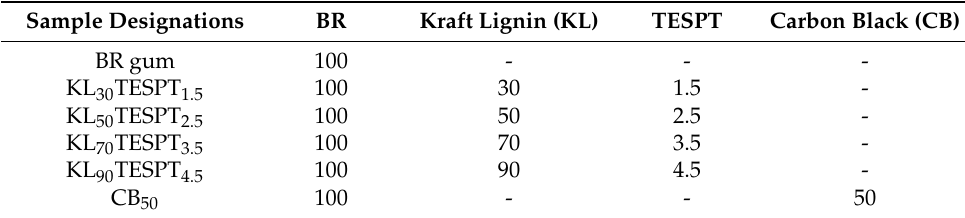
Table 1. Mixing recipe of all rubber composites 1